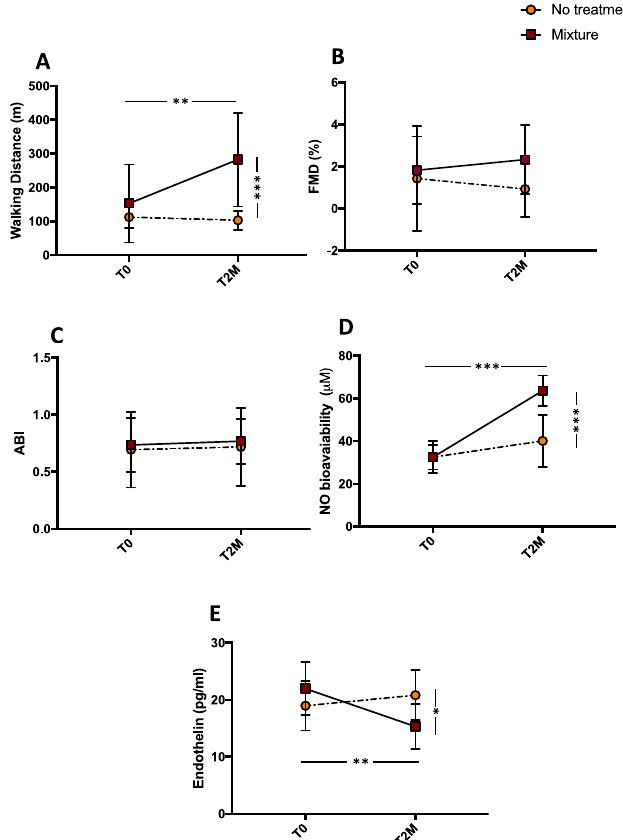
Figure 1. Maximal walking distance (MWD) ( A ), FMD ( B ), ABI ( C ), serum nitrite/nitrate ( D ), and endothelin-1 ( E ) before (T0) and 2 months (T2M) after mixture intake ( n = 10) or no-treatment ( n = 10) in peripheral artery disease patients. Data are expressed as mean ± SD. * p < 0.05, ** p < 0.01, *** p < 0.001. Compared with the baseline, MWD increased significantly after mixture intake (from 152.7 ± 115.5 to 282 ± 138.5 m, ** p < 0.01); no changes were observed after no treatment (from 112.1 ± 32.5 to 103 ± 27.8 m, p = 0.515 for MWD) (Figure 1A). Conversely, FMD showed an improvement after mixture intake even if it did not reach statistical significance (from 1.82 ± 0.5 to 2.33 ± 0.5%, p = 0.492) (Figure 1B). In addition, a non-significant wors- ening trend was observed after no treatment (from 1.42 ± 0.8 to 0.93 ± 0.4%, p =